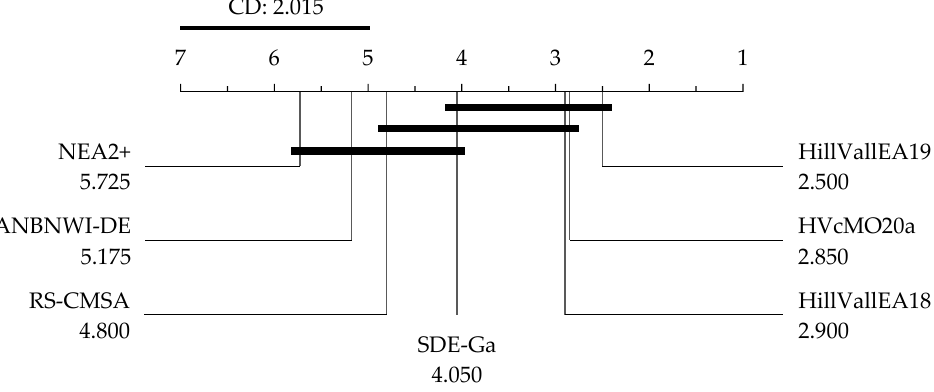
Figure 5. Nemenyi test regarding F1. Connected optimizers are not statistically different.